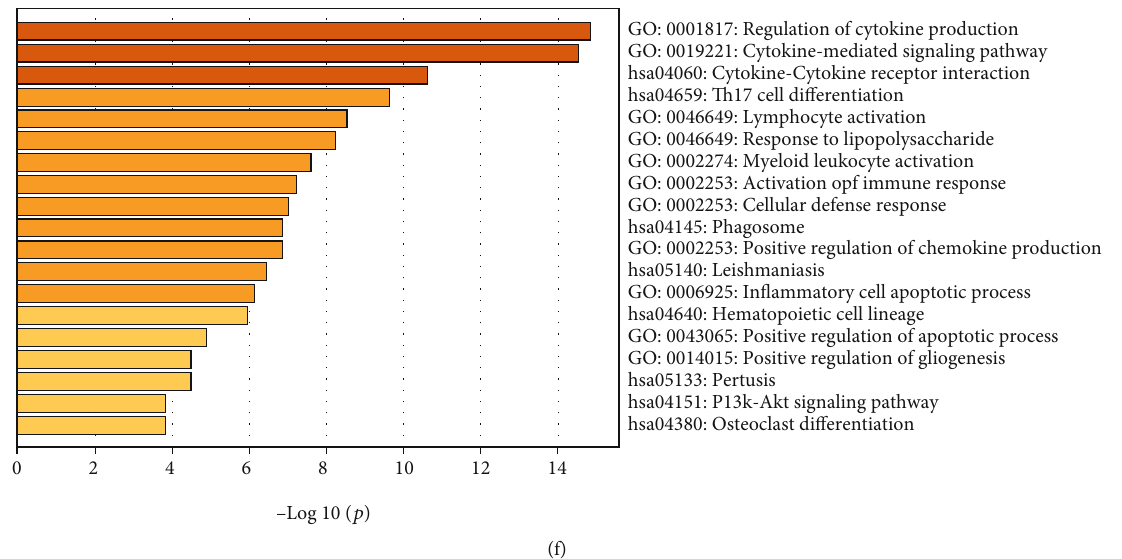
Figure 5: Two modules obtained from upregulated-PPI network and its functional enrichment analysis. (a) 149 upregulated in fl ammation- related DE mRNAs in COVID-19 were collected with Venn analysis. (b) PPI network of upregulated in fl ammation-related DE mRNAs. (c, d) Signi fi cant clustered modules from the PPI network. Red rectangles represent upregulated genes. The GO-BP terms and KEGG pathways enrichment analysis for module 1 (e) and module 2 (f), respectively, using the Metascape